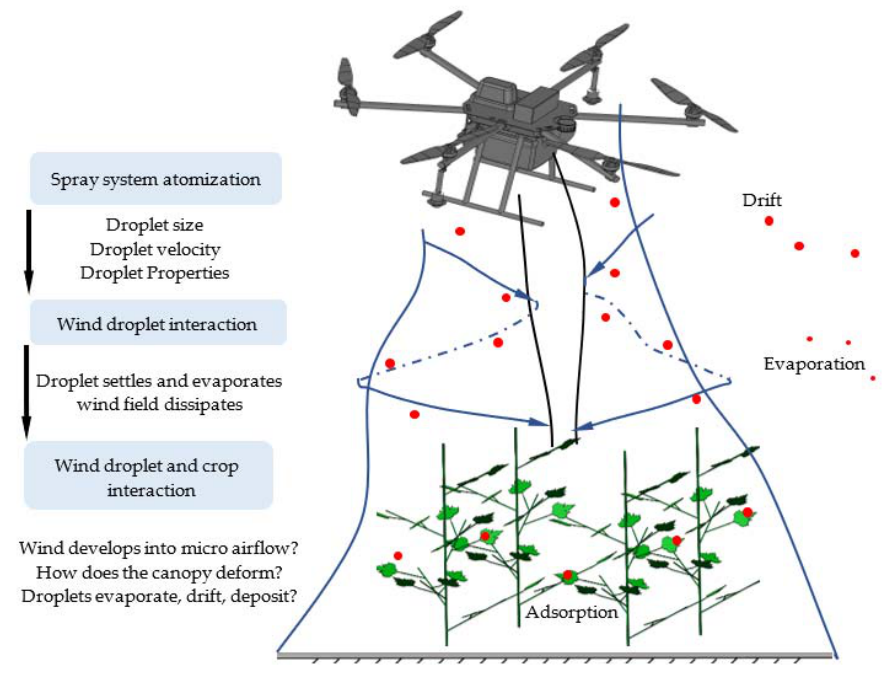
Figure 1. Schematic diagram of flight pesticide application of multi ‐ rotor plant protection